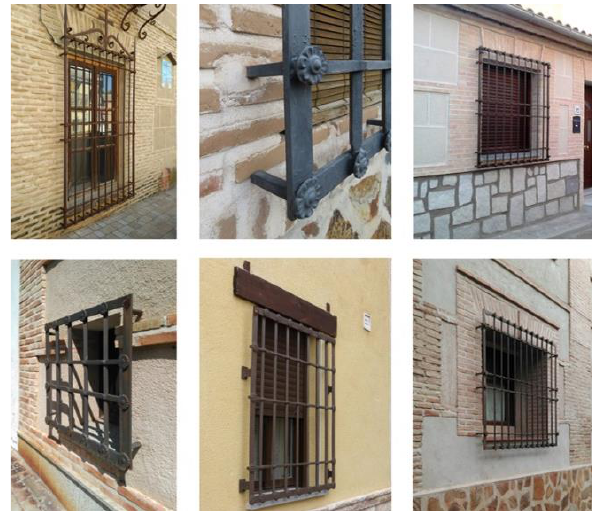
Figure 4. Examples of iron grilles noted as